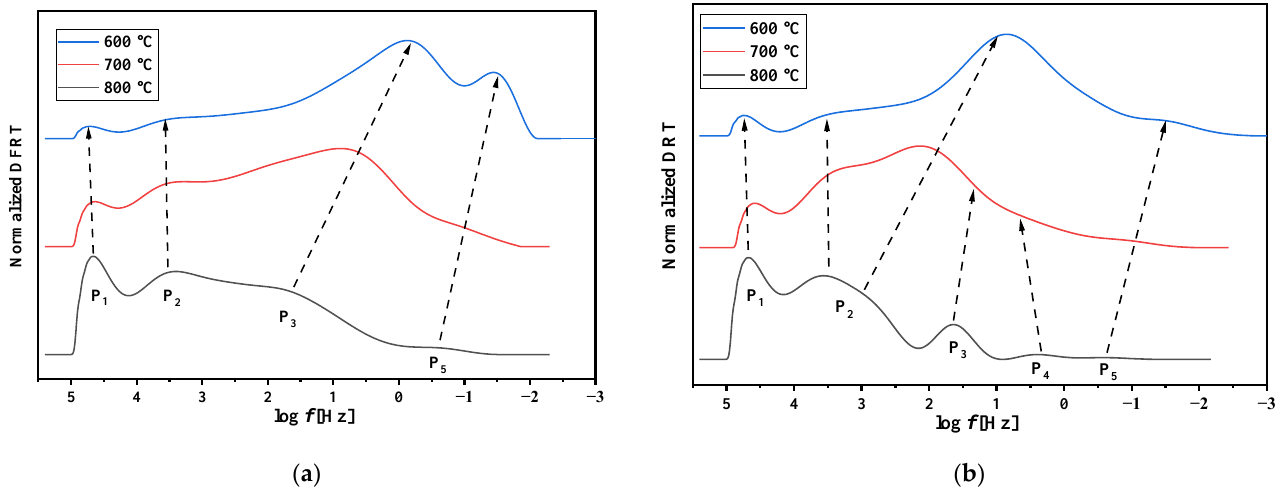
Figure 10. DFRTs obtained from the EIS data (at 600 – 800 °C) for the NCNCO00/SDC ( a ) and NCNCO02/SDC ( b ) symmetrical cells with the functional layers sintered at 1000 ° C.